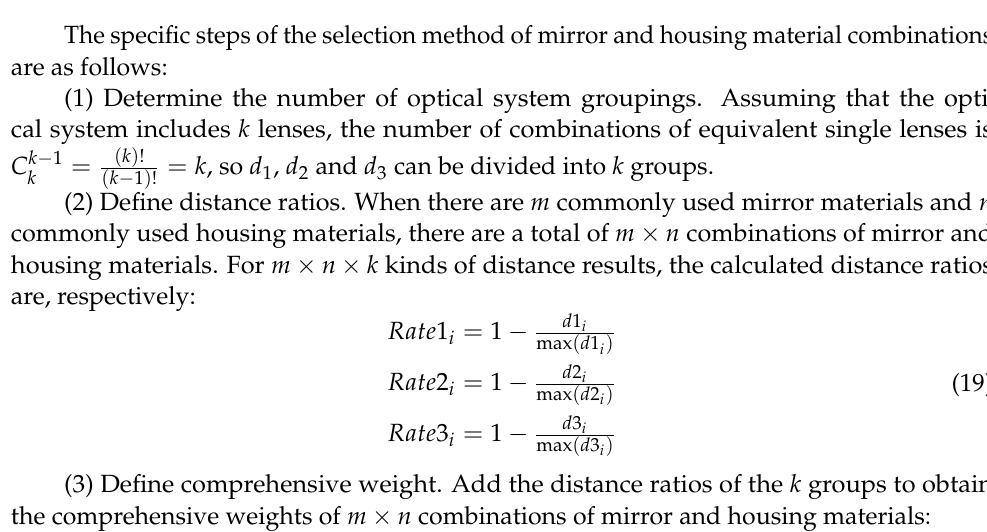
Figure 4. Evaluation method of mirror and housing material